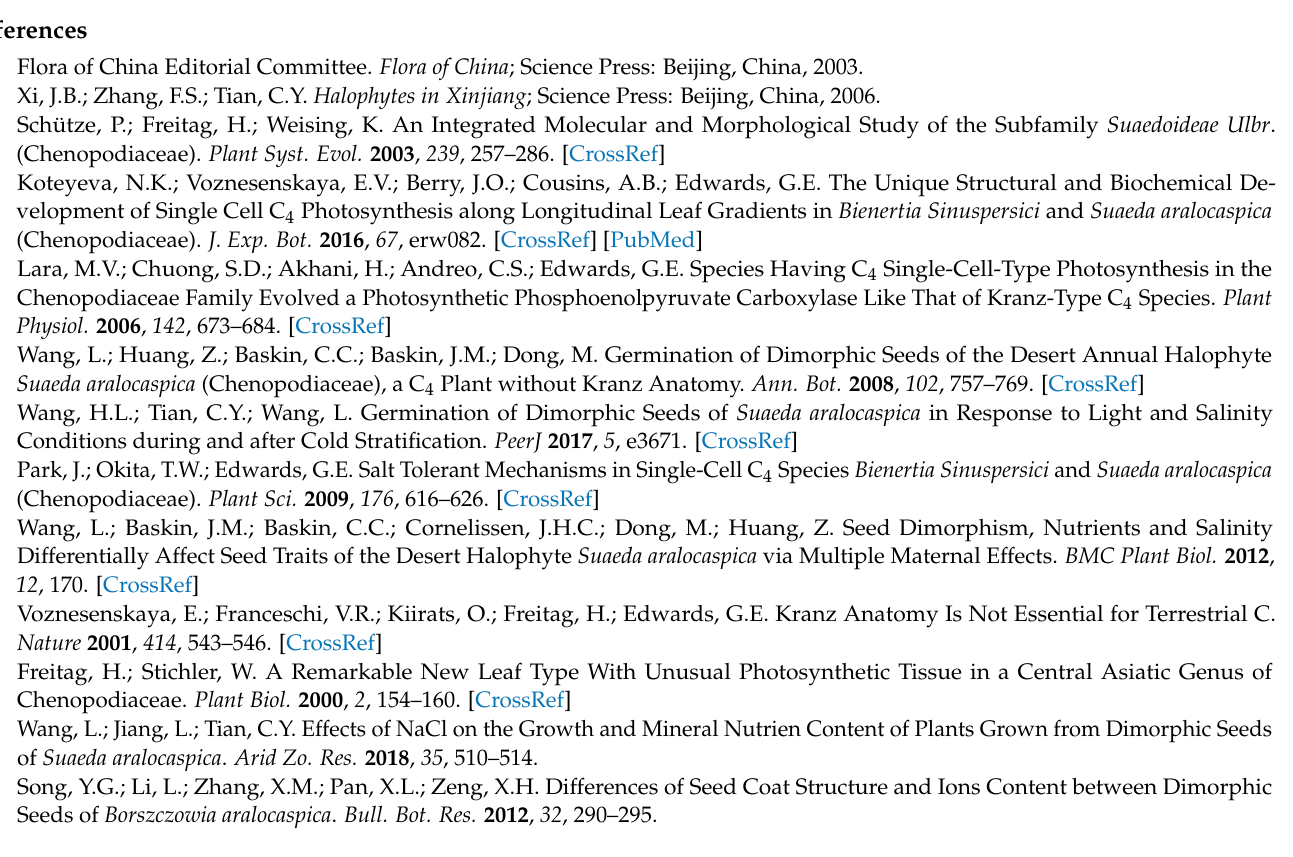
Table S4: 25 different treatments with 0.1% HgCl 2 as the secondary disinfector to sterilize black seeds of Suaeda